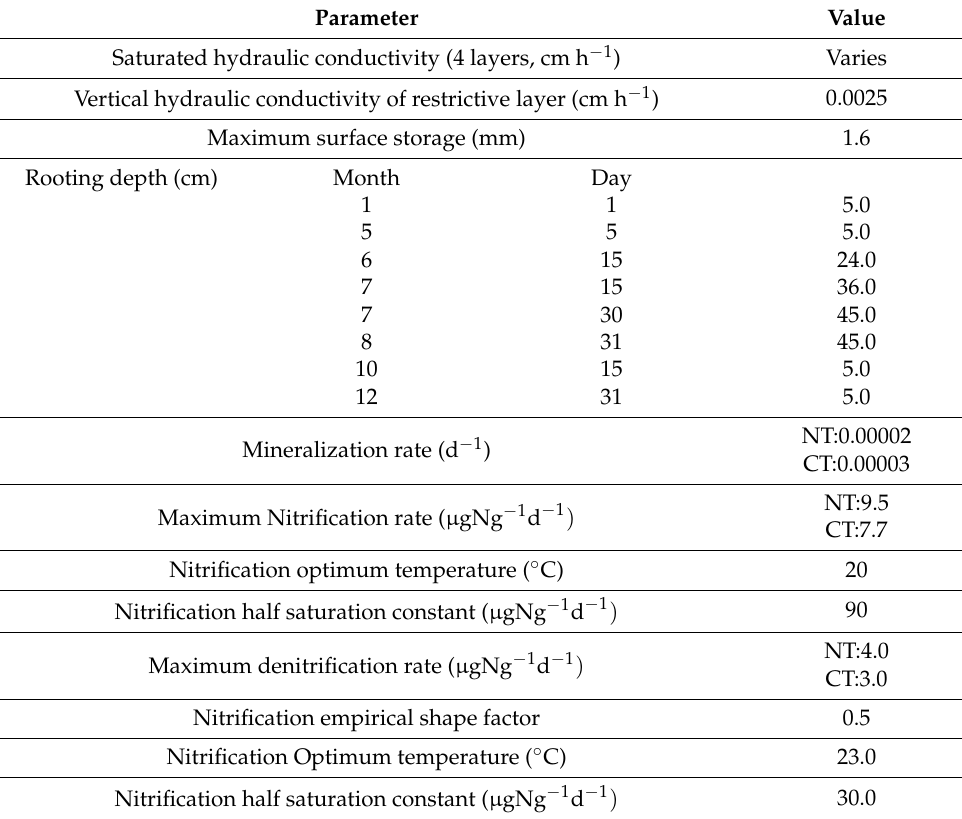
Table 4. Parameters Used in Calibration of DRAINMOD